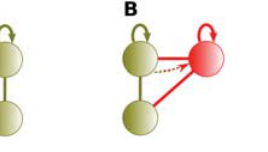
PLoS Computational Biology |